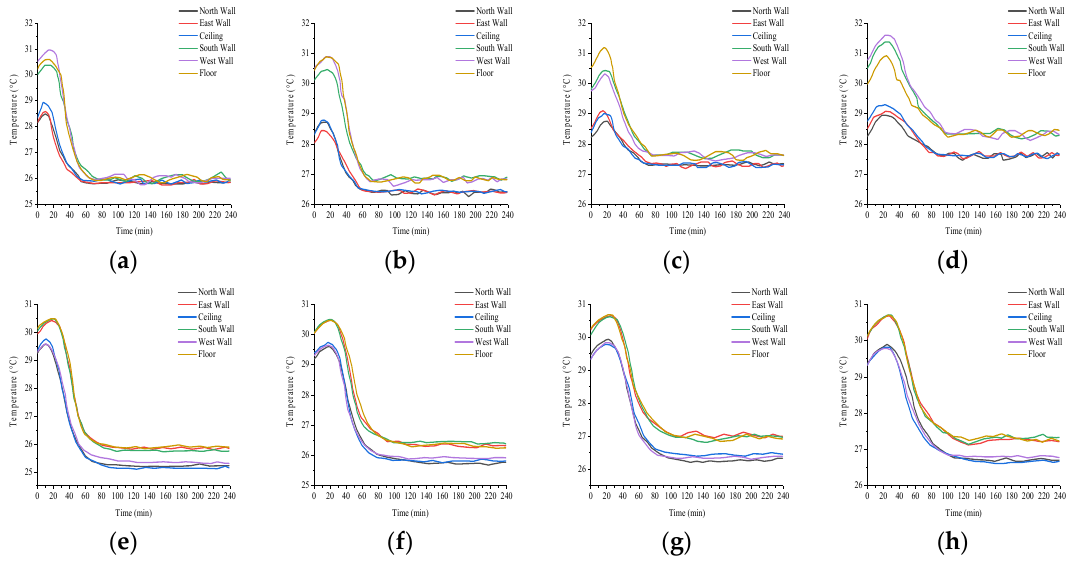
Figure 5. The temperature change of envelope over time under different supply water temperature with CTRC (( a – d ) for 12 °C, 14 °C, 16 °C and 18 °C, respectively) and CRC (( e – h ) for 12 °C, 14 °C, 16 °C and 18 °C, respectively). Copper tube radiant cooling (CTRC), capillary radiant cooling (CRC).